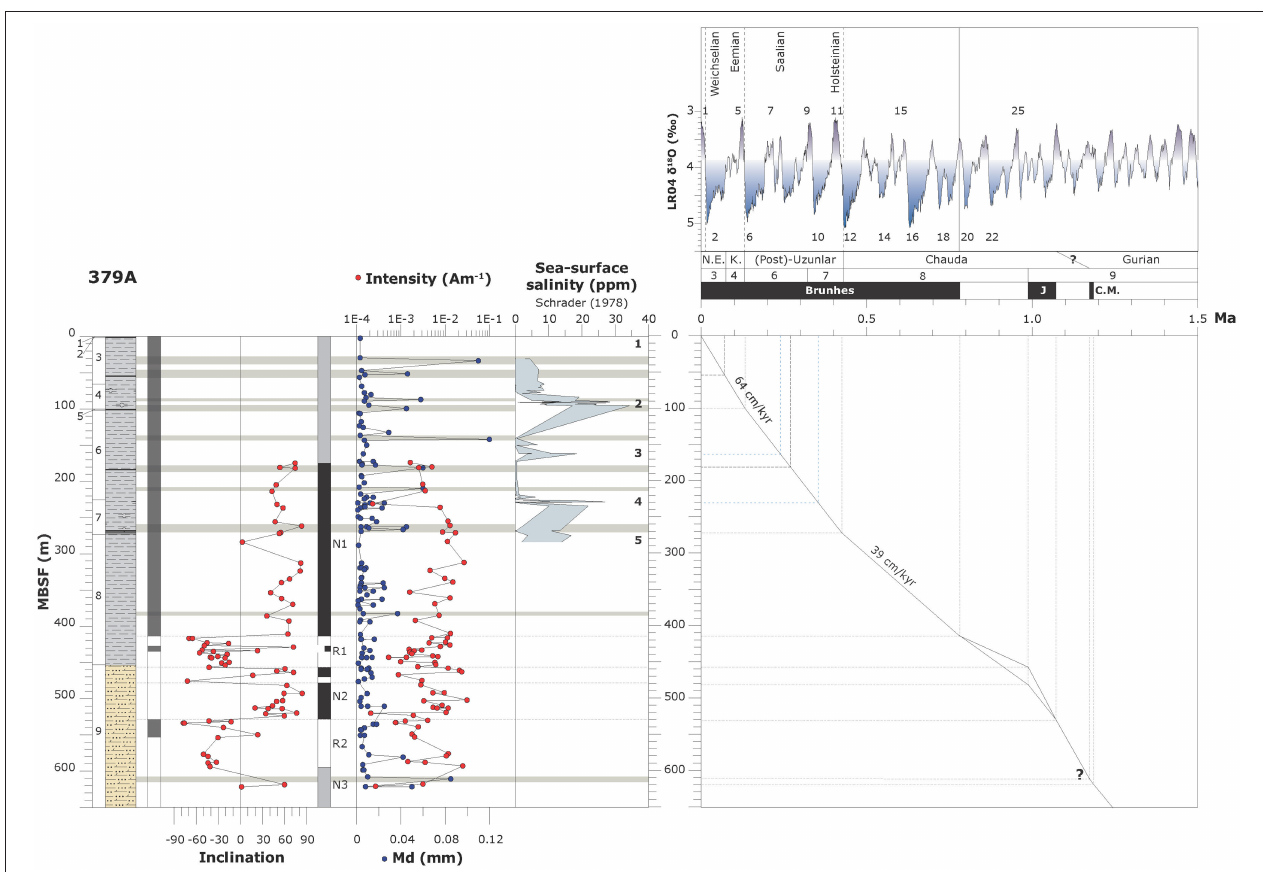
FIGURE 5 | Age-depth plot for Hole 379A. From left to right : Depth-scale; lithological units; lithology (similar to Figure 1 ); polarity interpretation by Giovanoli (1979), black (white) normal (reversed); Inclination data ( Giovanoli, 1979); Our polarity interpretation; Polarity chron label; grain size [mean diameter, MD (mm), Trimonis and Shimkus, 1978 ] and NRM intensity (Giovanoli, 1979); diatom-based sea-surface salinity (Schrader, 1978), numbers (1–5) indicate marine diatom assemblages. Gray horizontal bands indicate coarse (turbiditic) lithologies and dotted black lines magnetic reversals. From top to bottom: Terrestrial chronostratigraphic units; stacked δ 18 O record of benthic foraminifera ( Lisiecki and Raymo, 2005) with numbered (inter) glacial stages; Black Sea regional stages (N.E. = New Euxinian, K. = Karangat) after Zubakov (1988); Hole 379A lithological units; Geomagnetic Polarity (Hilgen et al., 2012; J = Jaramillo, C.M. = Cobb Mountain); Age